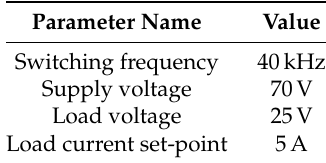
Table 6. Experimental results parameters.